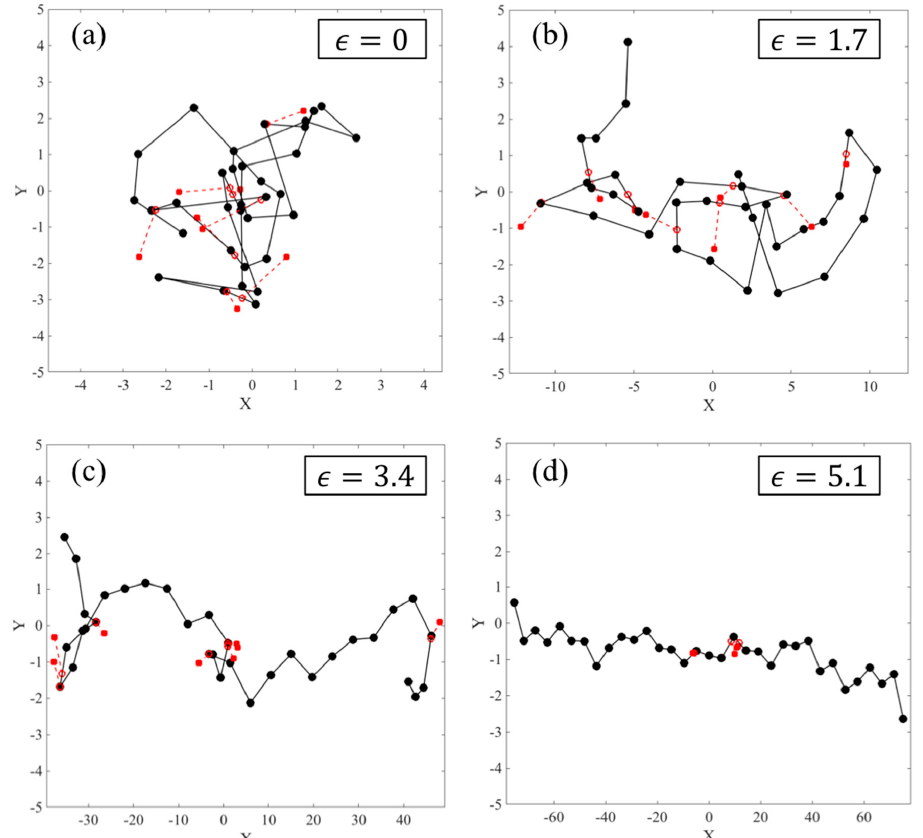
Figure 7. Evolution of a sample chain with N s = 32 ( Z 0 = 8) at Wi R = 16, at Hencky strains of ( a ) (cid:101) = 0, ( b ) (cid:101) = 1.7, ( c ) (cid:101) = 3.4, and ( d ) (cid:101) = 5.1. Notice the x scale, but not the y scale, is increased in range at large strains. Main chain beads and springs are shown with black circles and lines, respectively, while slip-springs are shown in red, extending from their anchoring points marked with solid red circles to their positions on the chain, marked with open red circles. A maximum slip-spring force is used, and regeneration of slip-springs is turned off. Polymers 2018 , 10 , x FOR PEER REVIEW